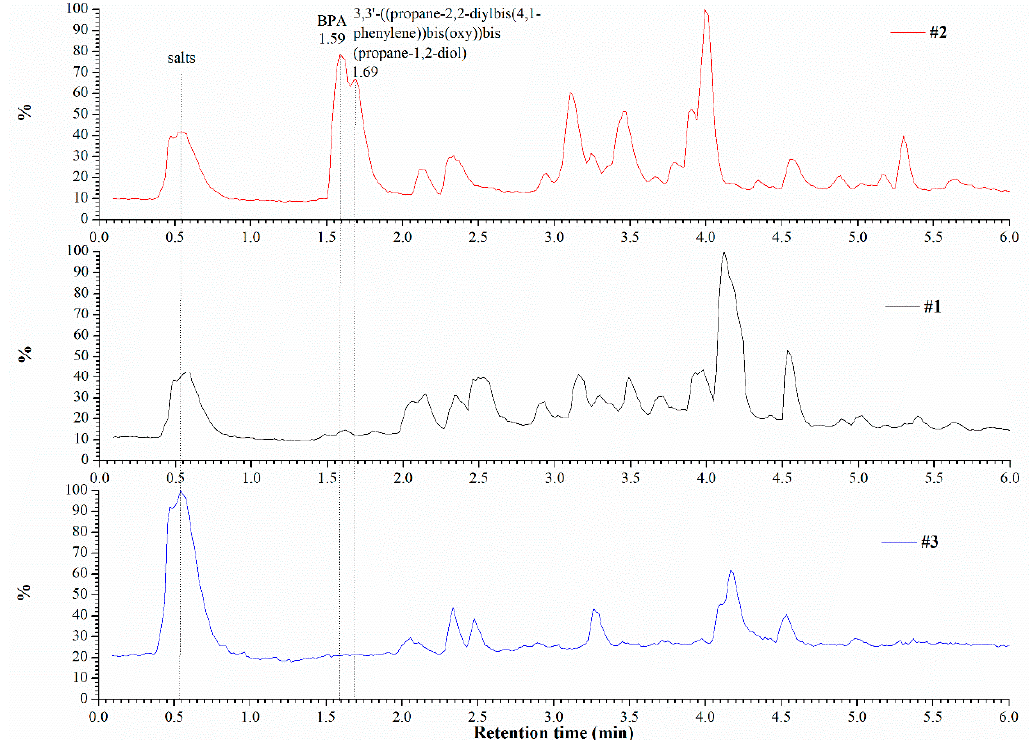
Figure 10. Chromatograms of the three sample compositions in the positive mode of the mass spectrometer. #1—Davis epoxy resin LY 5052 with bacteria, #2—Davis epoxy resin LY 5052 without bacteria, #3—Davis and bacteria without epoxy resin.